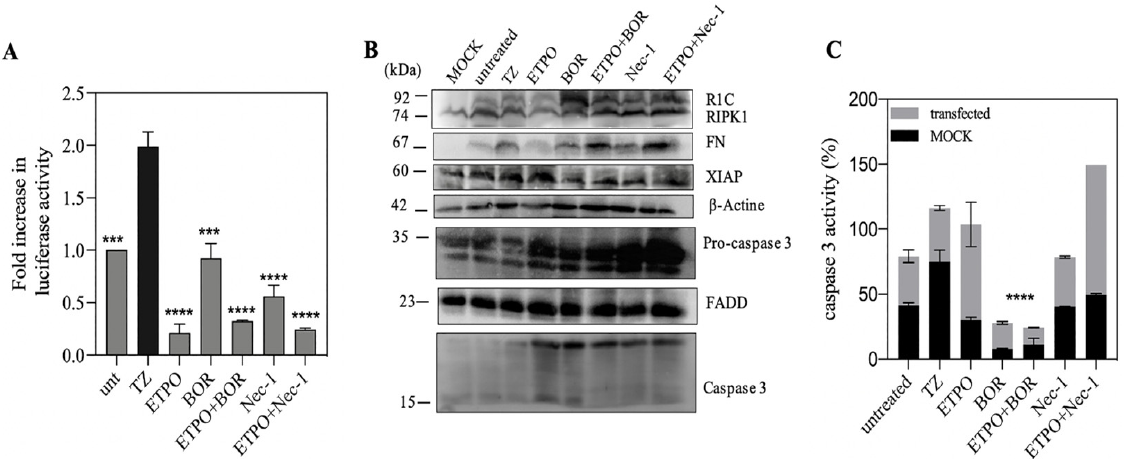
Figure 5. Etoposide effect in presence of bortezomib and Nec-1 based on luciferase activity. ( A ) After 24 h of co-transfection of FN and R1C with PEI. SH-SY5Y cells pre-treated with TZ and 2h later treated with ETPO (50 µM), BOR (40 nM) and Nec-1(5 µM). 18 h later cells were lysed for luciferase activity. ( B ) Western blot of recombinant and endogenous proteins. ( C ) Caspase 3 activity based on cleavage of Ac-DEVD-AMC. *** p ≤ 0.001; **** p ≤ 0.0001.